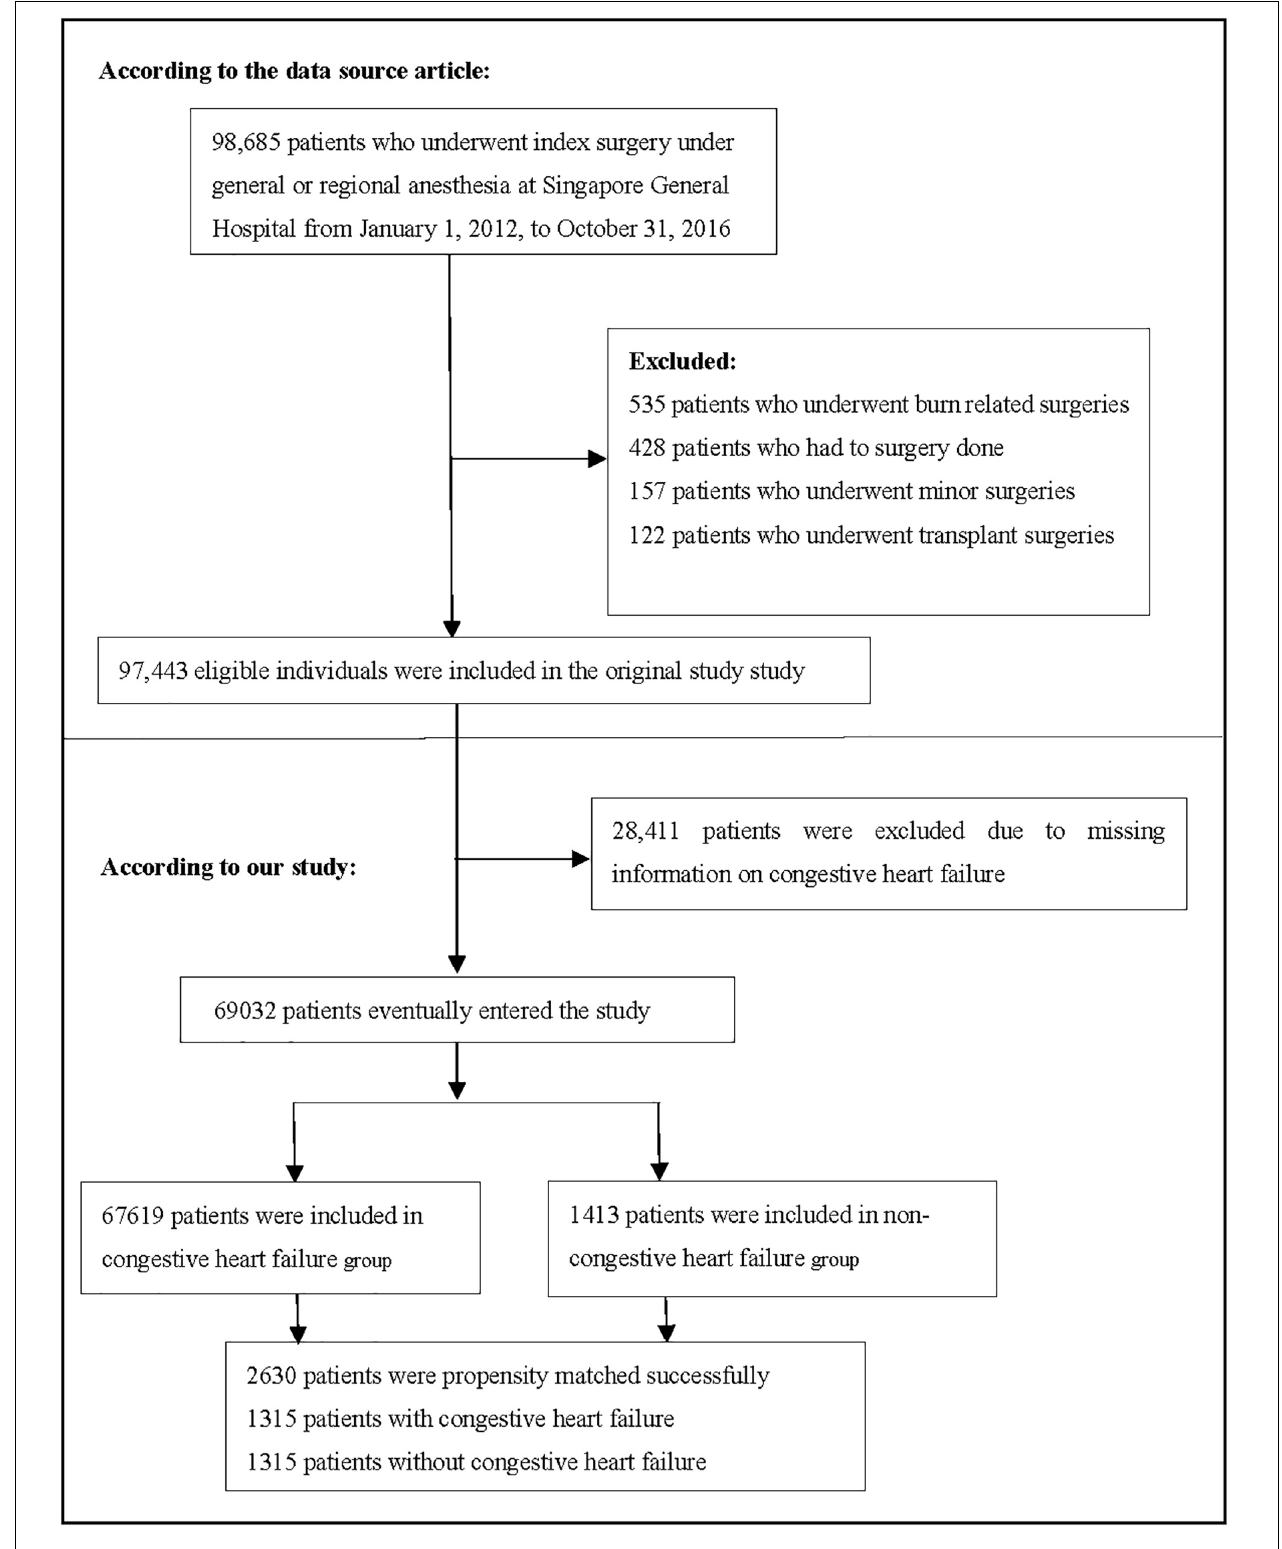
FIGURE 1 | Flowchart of study participants. It showed the process of screening participants.